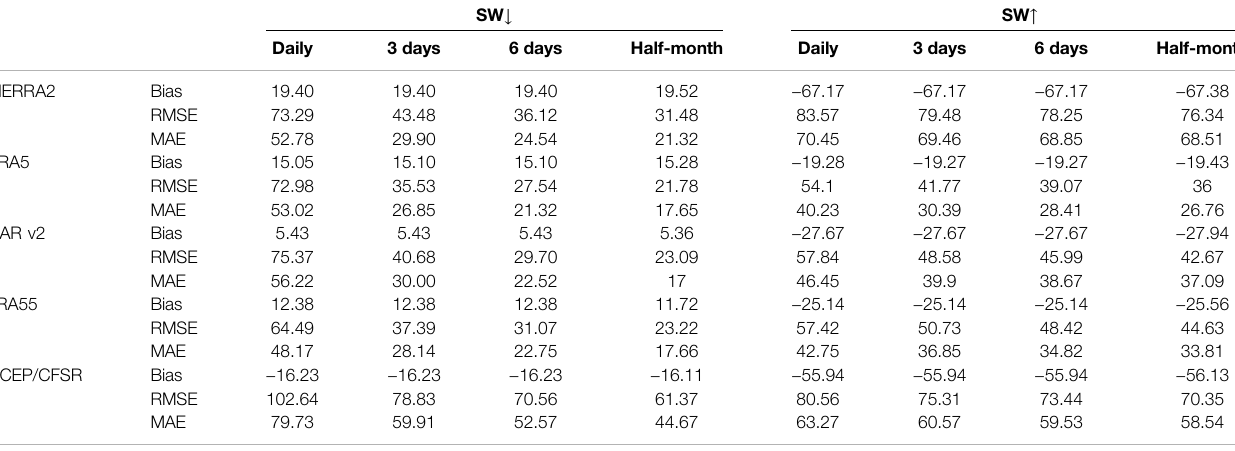
TABLE 3 | Evaluation of the day scales of shortwave radiation from fi ve sets of reanalysis datasets.